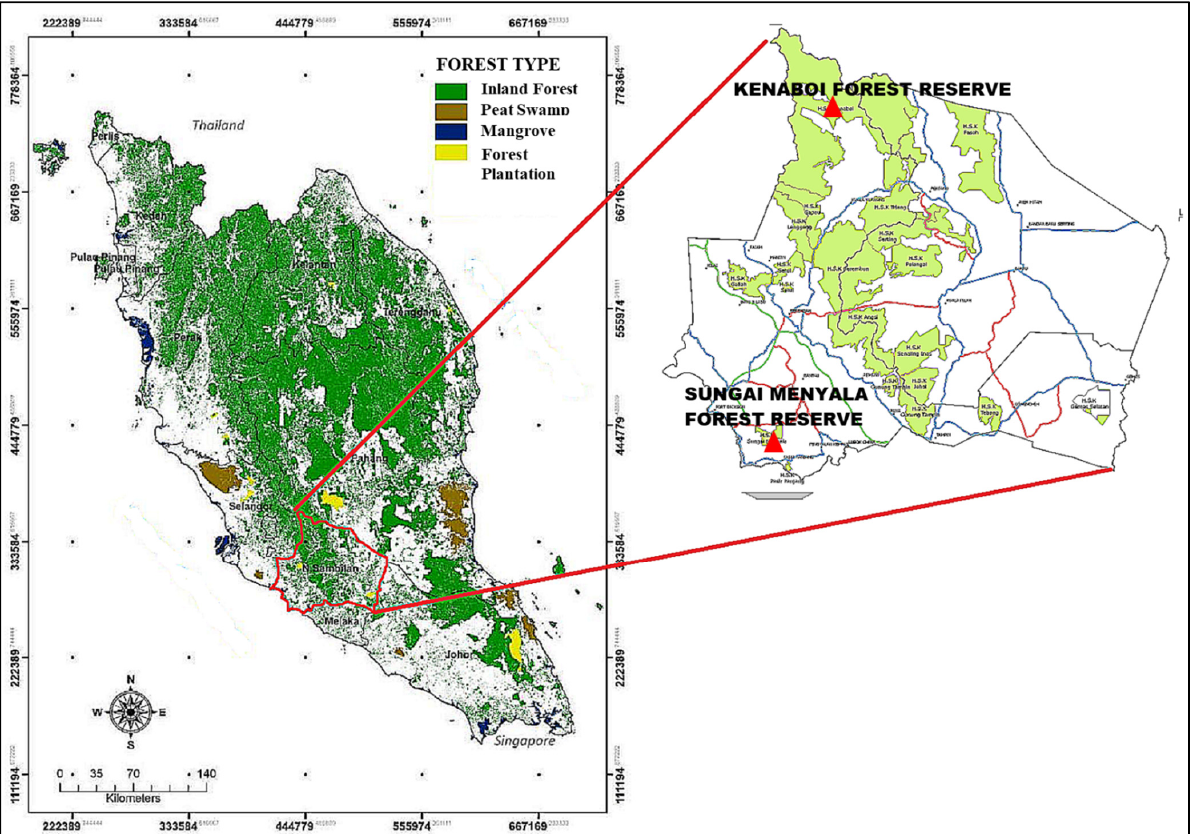
Figure 1. Location of Kenaboi Forest Reserve, Jelebu, Negeri Sembilan, Malaysia. Source: Modified from Forest Department of Negeri Sembilan.